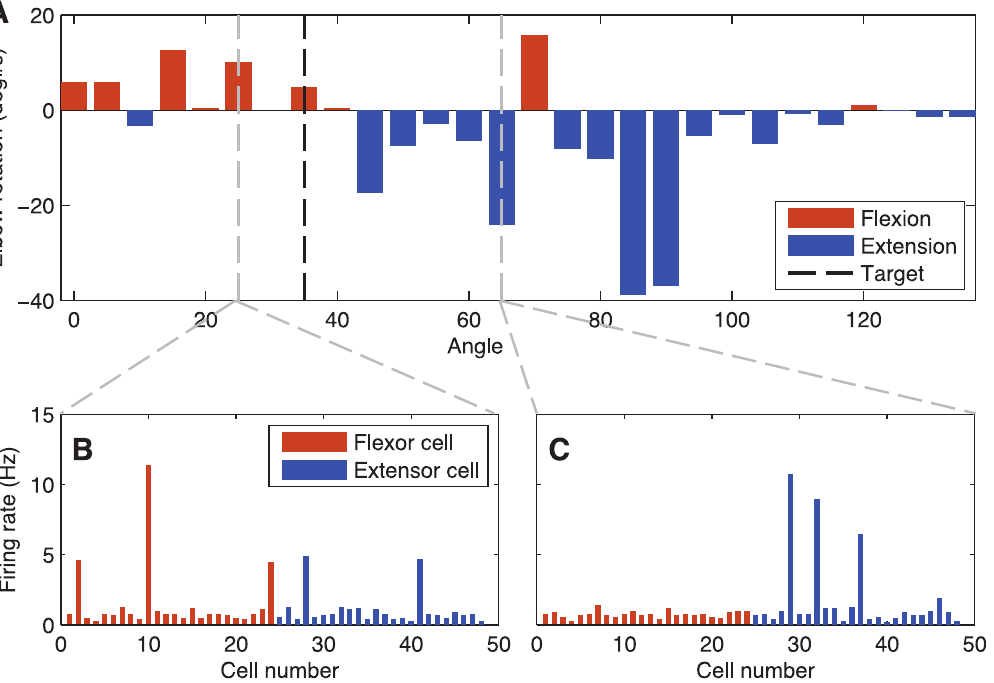
Figure 6. Learned EM activation for target of 35 u . A. Rotation command (differences of flexor and extensor EM rates) as a function of angle. Example firing rates for individual cells are shown at two representative arm angles: 25 u (B, extended relative to target) and 65 u (C, relatively